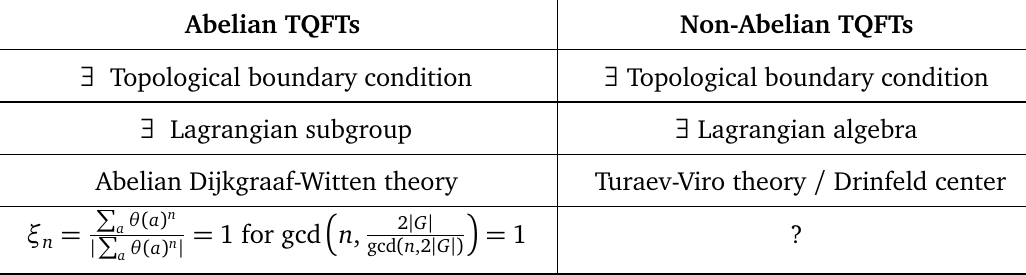
is the higher central charge n